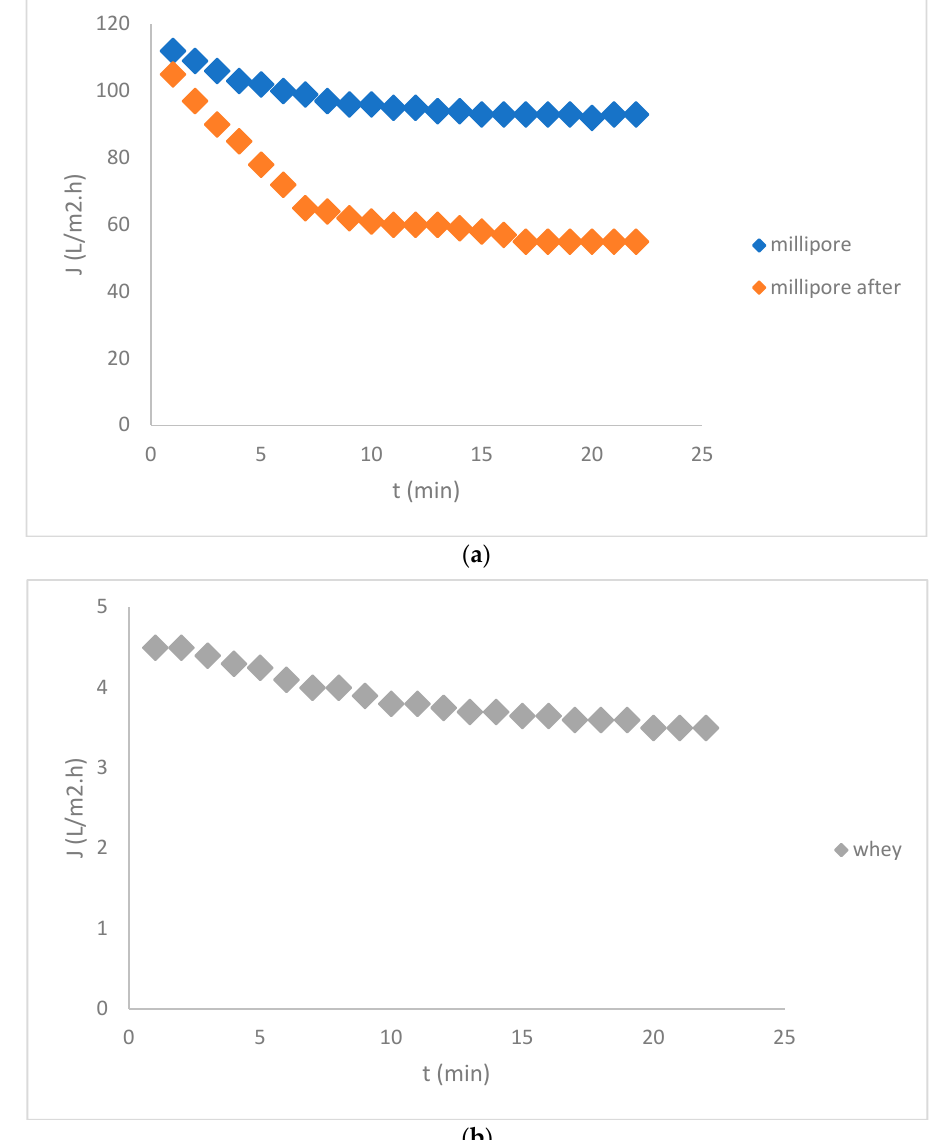
Figure 4. Flux dependent on time for the ceramic membrane, ( a ) For Millipore water before and after whey filtration and ( b ) Whey.